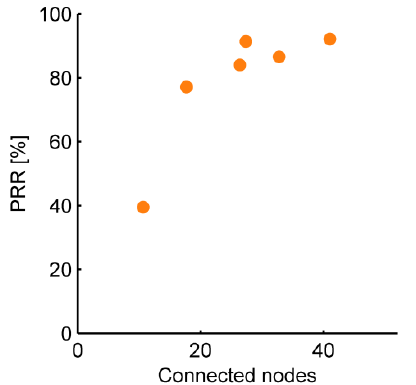
Figure 13. Network PRR versus number of connected nodes in the network when using CTP. PRRs are computed monthly and the number of connected nodes is computed as the average of daily connected nodes within the network in the same time period.